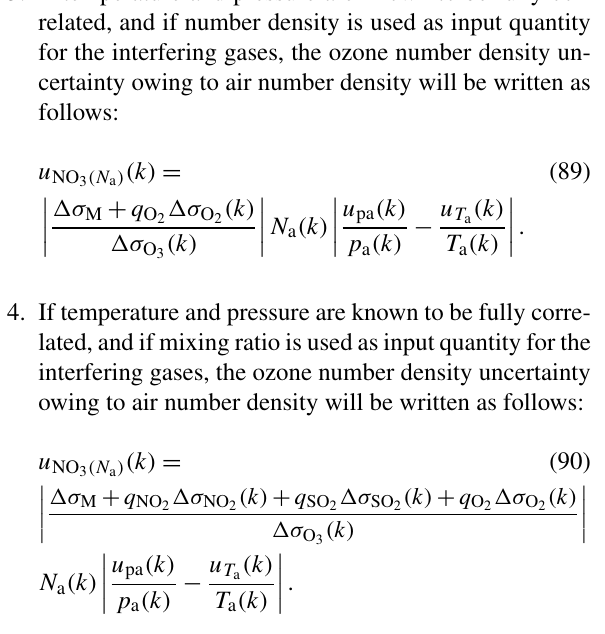
Figure 14. Stratospheric ozone relative uncertainty (left) and mix- ing ratio uncertainty (right) as a function of air number density, temperature, and pressure uncertainty, for typical midlatitude spring conditions. The solid curves represent the ozone uncertainty per per- cent of air number density uncertainty, the dashed curves represent the ozone uncertainty per degree of air temperature uncertainty, and the dotted curves represent the ozone uncertainty per 0.1hPa of air pressure